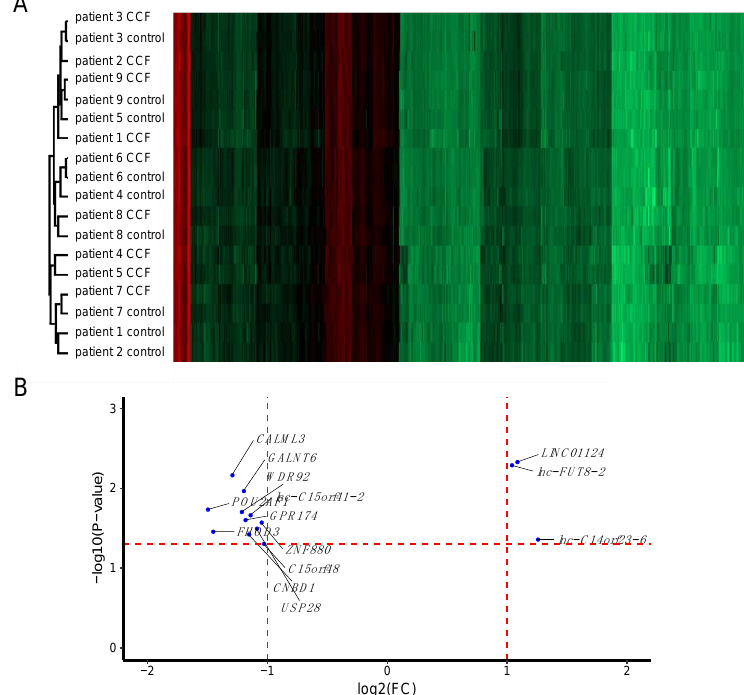
Figure 1. The transcriptome of CCF (clear cell foci) and control samples from human liver biopsy specimens. Control and CCF samples were laser-capture micro-dissected from cryosections and total RNA was used for microarray analysis. ( A ) Cluster analysis of the full dataset revealed larger inter-patient differences than differences between CCF and control samples. ( B ) Scatter plot of transcripts (mRNAs, miRNAs, and lncRNAs) with statistically significant differential expression in CCF vs. control samples. More transcripts show lower expression in CCF than in control samples. Horizontal red line: p- value = 0.05; vertical red lines: FC = 2-fold down- or up-regulation, respectively.